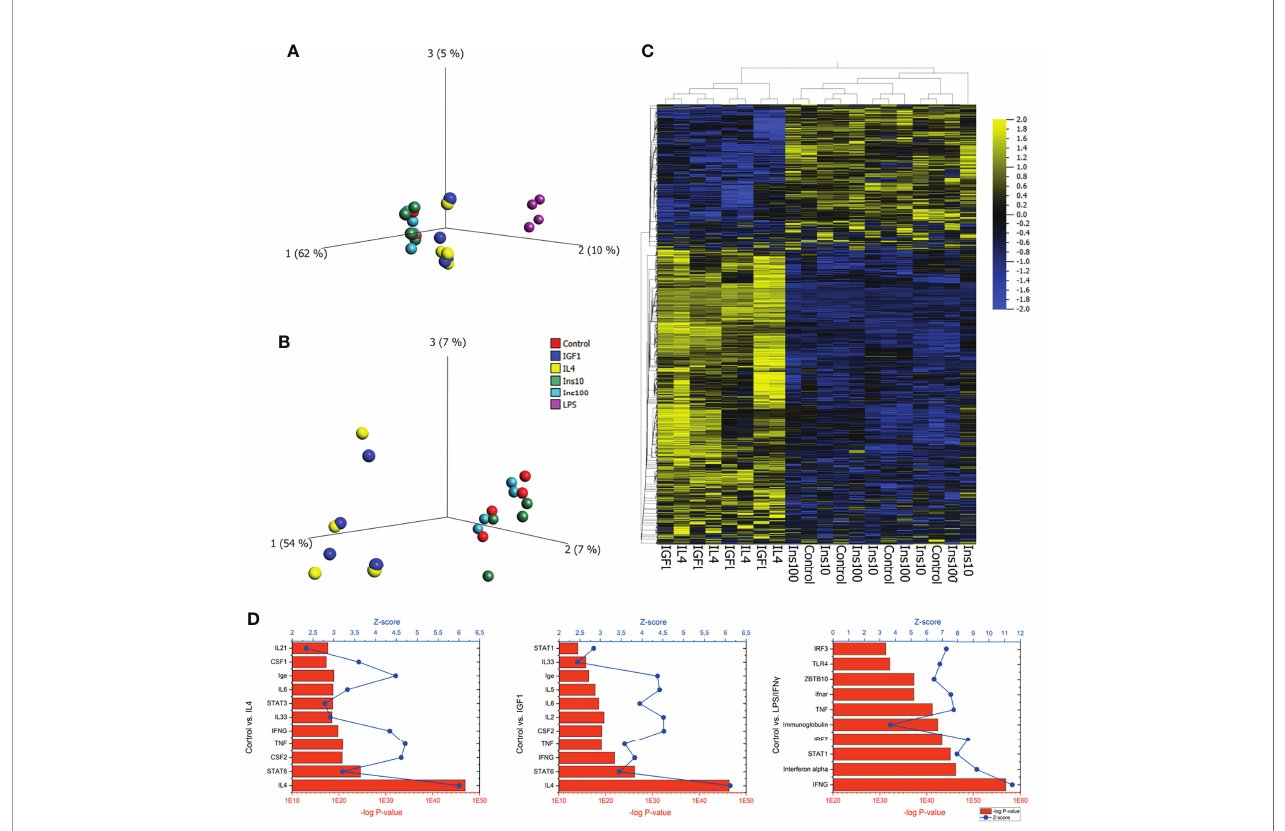
FIGURE 1 | IGF1 and IL4 induce almost identical transcriptional changes in neutrophils (A) PCA plot of bone marrow derived neutrophils, untreated or treated for 4 hours with LPS/IFN g (10/2 ng/mL), IL4 (20 ng/mL), IGF1 (10 ng/mL) or insulin (10 ng/mL and 100 ng/mL) after RNAseq analysis of transcriptomes shows 3 clusters of neutrophils. (B, C) A PCA plot (B) and a hierarchical clustered heatmap (C) without LPS/IFN g treated neutrophils shows that IL4 and IGF1 treated, as well as control and insulin treated neutrophils cluster together. (D) IPA analysis of control vs IL4, IGF1 and LPS/IFN g treated neutrophils identi fi ed upstream regulators. Bars represents – log p-values, line represents